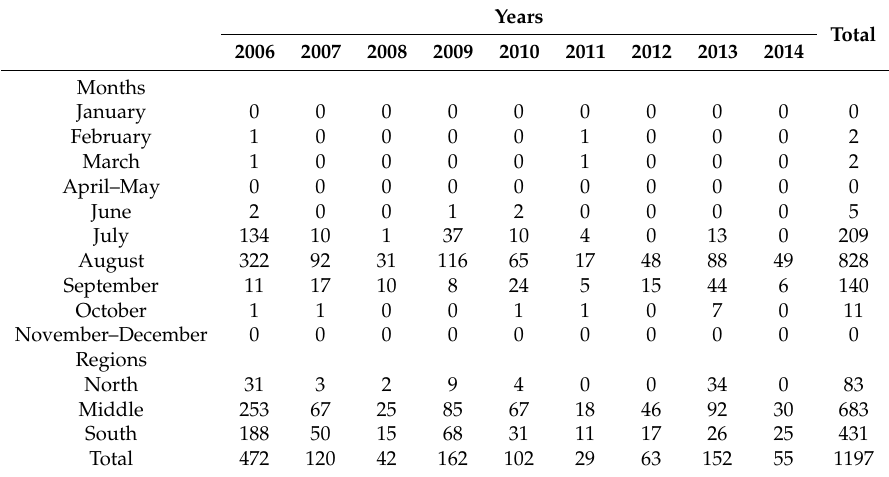
Table 1. Distribution of JE cases (2006–2014) by month and region in Shaanxi,